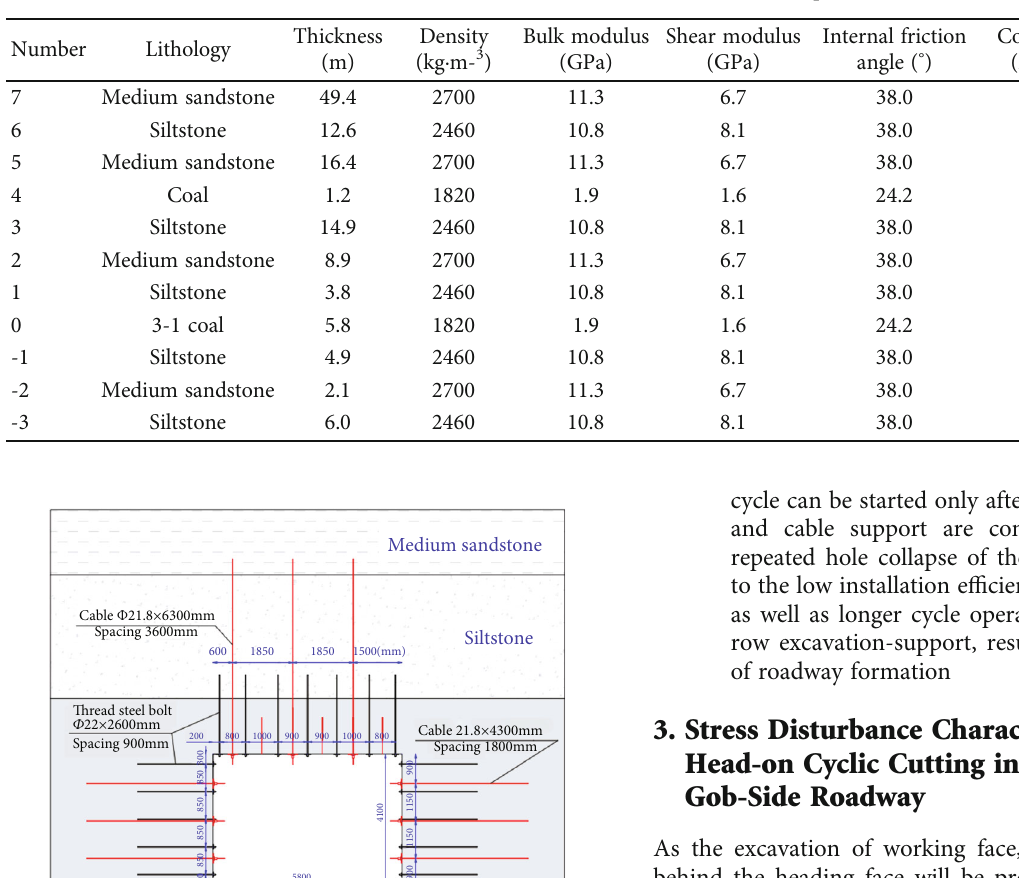
Table 1: Rock stratum occurrence and mechanical parameters.